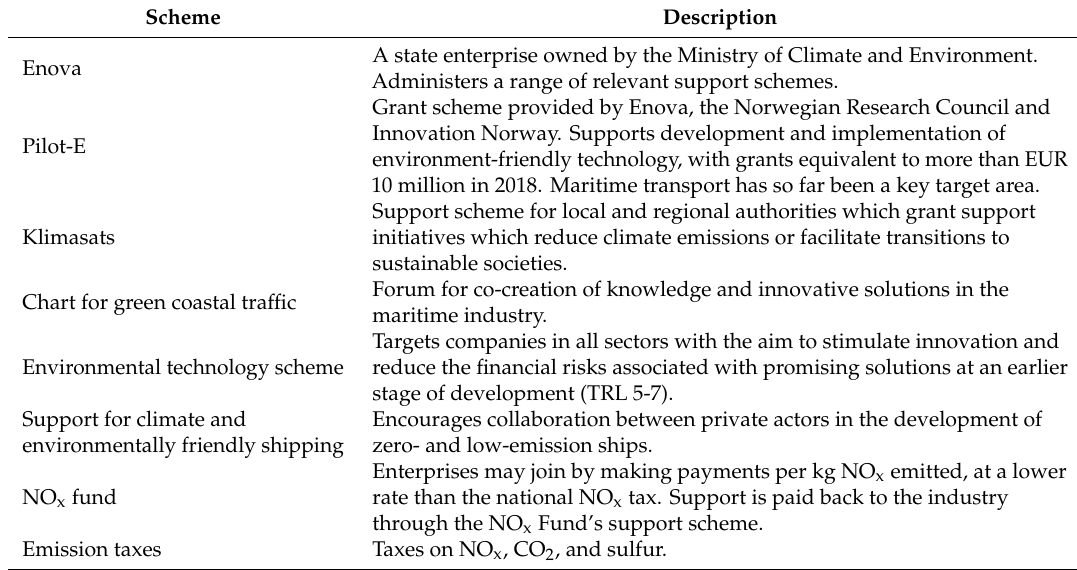
Table 1. Selection of instruments for sustainable maritime transport in